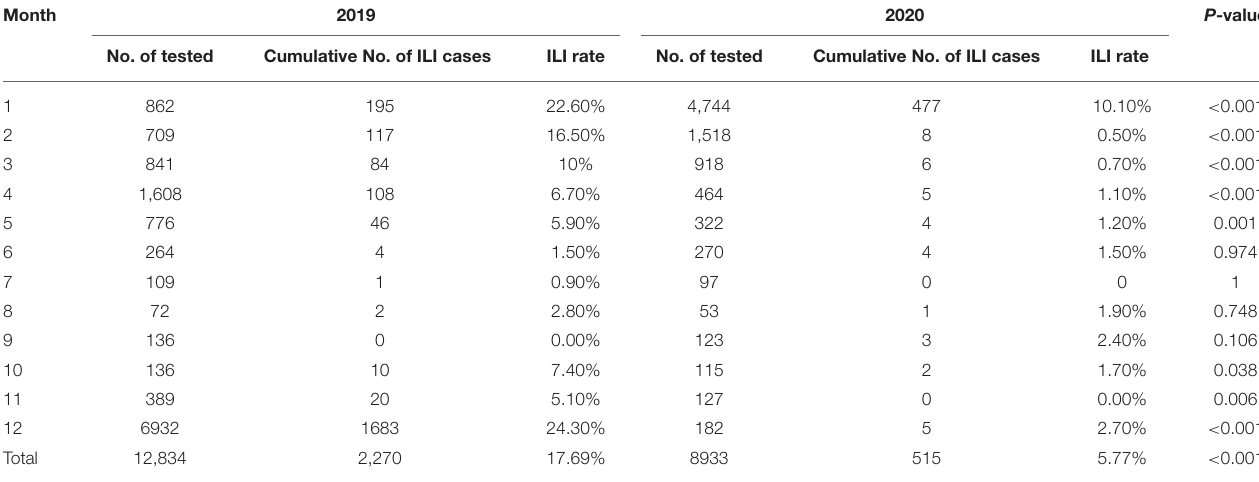
TABLE 1 | Progress of influenza A-like illness rate in 2019 and